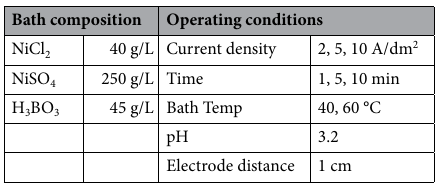
Table 2. Bath composition and operating conditions for semi-bright Watt’s solution Ni